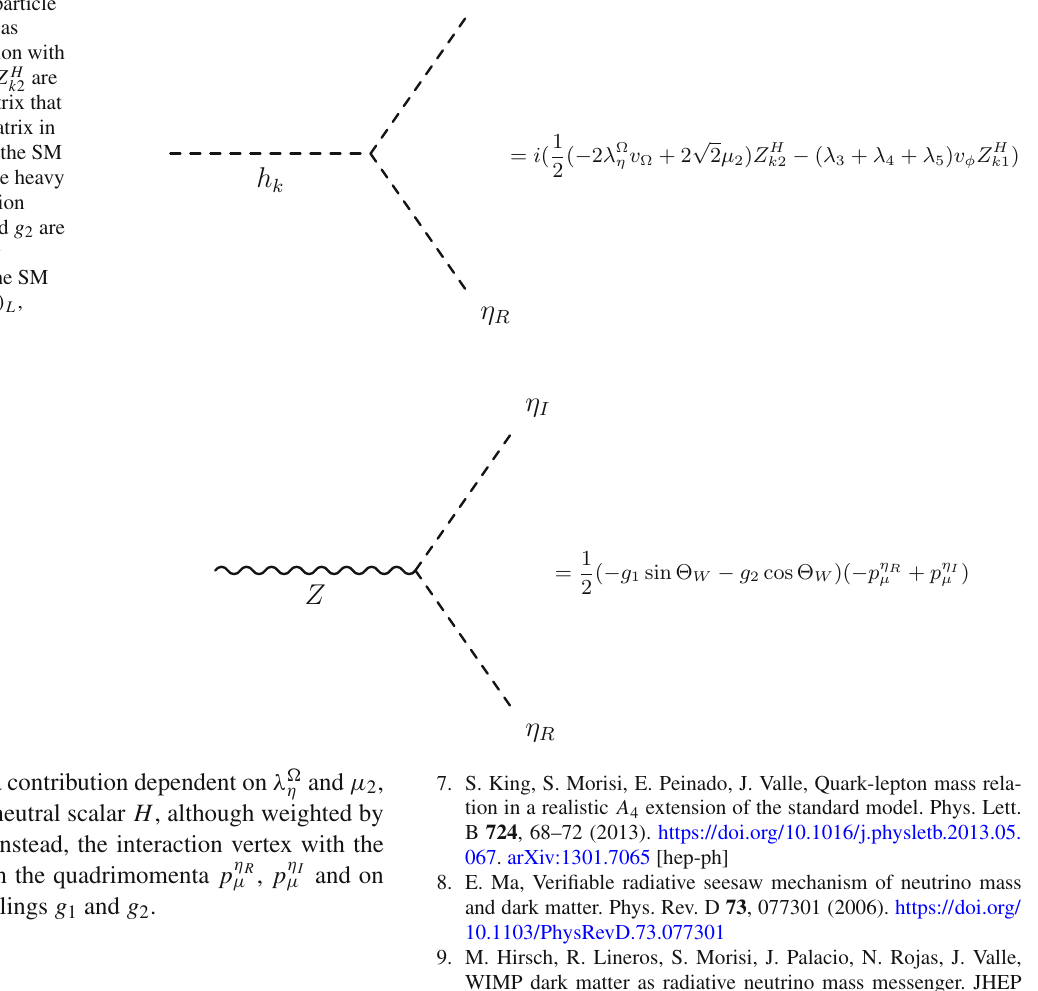
Fig. 13 Relevant η R interaction vertices. All particle momenta are considered as incoming. In the interaction with neutral scalars, Z H and Z H are k 1 k 2 entries of the mixing matrix that diagonalizes the mass matrix in Eq. (11) ( k = 1 refers to the SM Higgs h 0 and k = 2 to the heavy scalar H ). In the interaction with the Z 0 boson, g 1 and g 2 are the electroweak coupling constants associated to the SM groups U ( 1 ) Y and SU ( 2 ) L ,